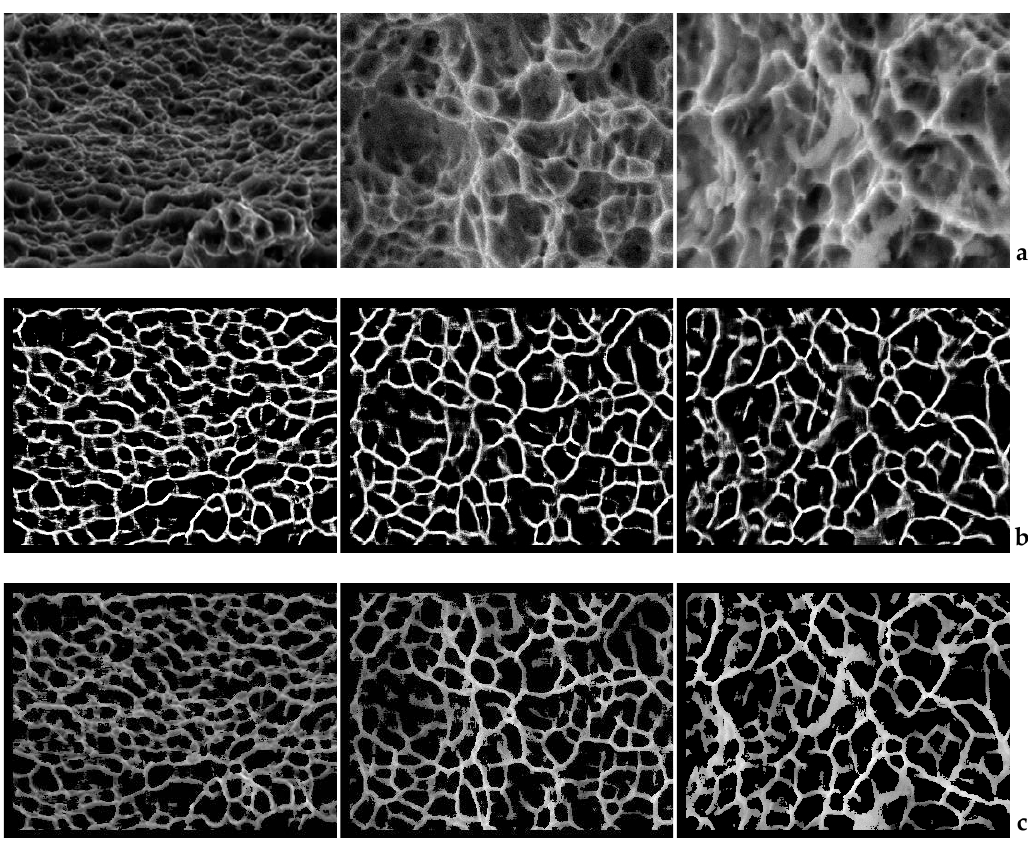
Figure 6. ( a ) SEM images of the titanium alloy VT23M (first image) and VT23 (second and third images) [26]; ( b ) visual representation of the result from the output of the neural network; ( c ) the result of detecting dimples (black spots), which is imposed on the initial SEM images.